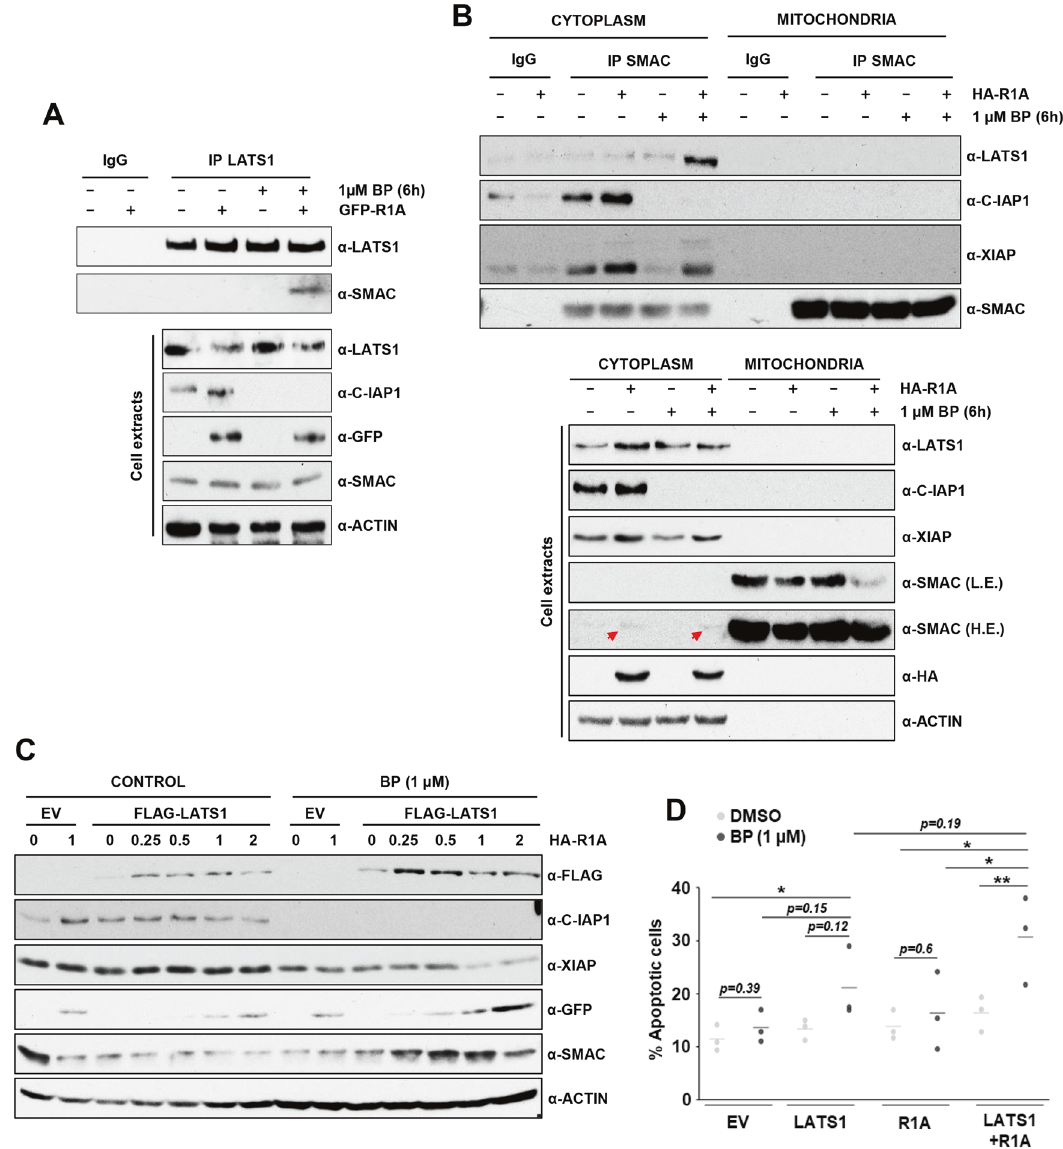
Fig. 7 Birinapant treatment of A375 cells promotes LATS1-SMAC interaction followed by XIAP degradation and apoptosis. A Endogenous LATS1-SMAC interaction in A375 cells transfected with GFP-RASSF1A or the corresponding empty vector assessed by co-immunoprecipitation upon 1 µM Birinapant (BP) treatment overnight (or corresponding amount of DMSO). Endogenous LATS1 was immunoprecipitated and levels of immunoprecipitated LATS1 and SMAC are shown. Normal IgG was used as negative control for the IP (upper panel). Total levels of LATS1, C- IAP1, GFP-RASSF1A and SMAC corresponding to LATS1 immunoprecipitation are shown (lower panel). Actin levels were used as loading control. B Subcellular fractionation of A375 cells transfected with HA-RASSF1A or the corresponding empty vector and treated with 1 µM BP for 5 hours (or the corresponding amount of DMSO) followed by SMAC immunoprecipitation from each of the fractions. Levels of SMAC and co-immunoprecipitated LATS1, C-IAP1 and XIAP are shown (upper panel). Normal IgG was used as negative control. Total levels of LATS1, C- IAP1, XIAP, SMAC and HA-RASSF1A are shown (lower panel). Actin levels were used as loading control. C Total lysates corresponding to A375 cells transfected with FLAG-LATS1 and increasing amounts of GFP-RASSF1A (or corresponding empty vectors), followed by overnight starvation and 1 µM BP treatment as indicated. Levels of exogenous FLAG-LATS1 and GFP-RASSF1A and endogenous C-IAP1, XIAP and SMAC are shown. Actin levels were used as loading control. D Apoptosis assay of A375 cells transfected with FLAG-LATS1 and HA-RASSF1A as indicated and treated with 1 µM BP overnight. Apoptosis was measured by YoPro-PI staining. Data represent ±SD of 3 independent experiments. T.TEST: p ≤ 0.1*; p ≤ a Bruker nanoElute nano-lc chromatography system. Tryptic peptides were were selected for ms/ms using parallel accumulation serial fragmentation resuspended in 0.1% formic acid. Each sample was loaded onto an Aurora (PASEF). A scan range of (100 – 1700m/z) was performed at a rate of 10 UHPLC column (25 cm × 75 μ m ID, C18, 1.6 μ m; IonOpticks, Australia) and separated with an increasing acetonitrile gradient over 30 minutes at a fl ow rate of 300 nl/min. The mass spectrometer was operated in positive ion mode with a capillary voltage of 1500 V, dry gas fl ow of 3 l/min and a dry temperature of 180 °C. All data were acquired with the instrument mobility spectra data-dependent acquisition (TIMS DDA). Each peptide used operating in trapped ion mobility spectrometry (TIMS) mode. Trapped ions for protein identi fi cation met speci fi c Maxquant parameters, i.e., only